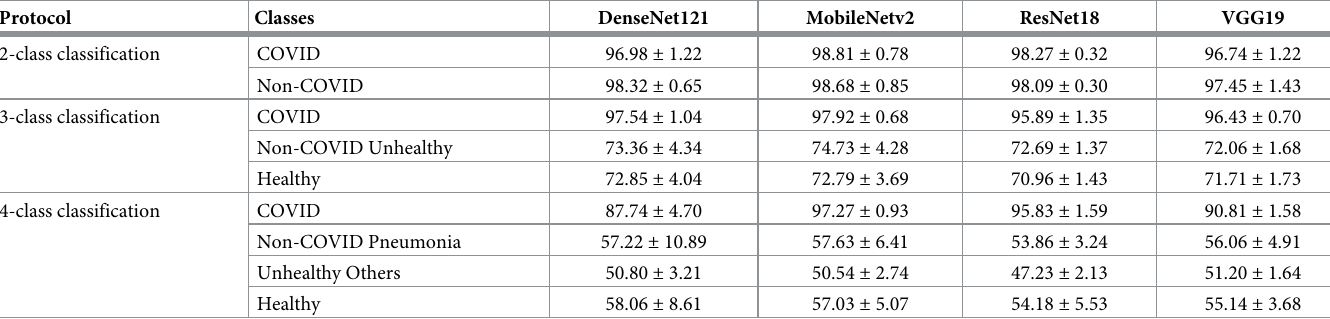
Table 5. Class-wise classification accuracy corresponding to existing deep learning algorithms for all classification protocols.